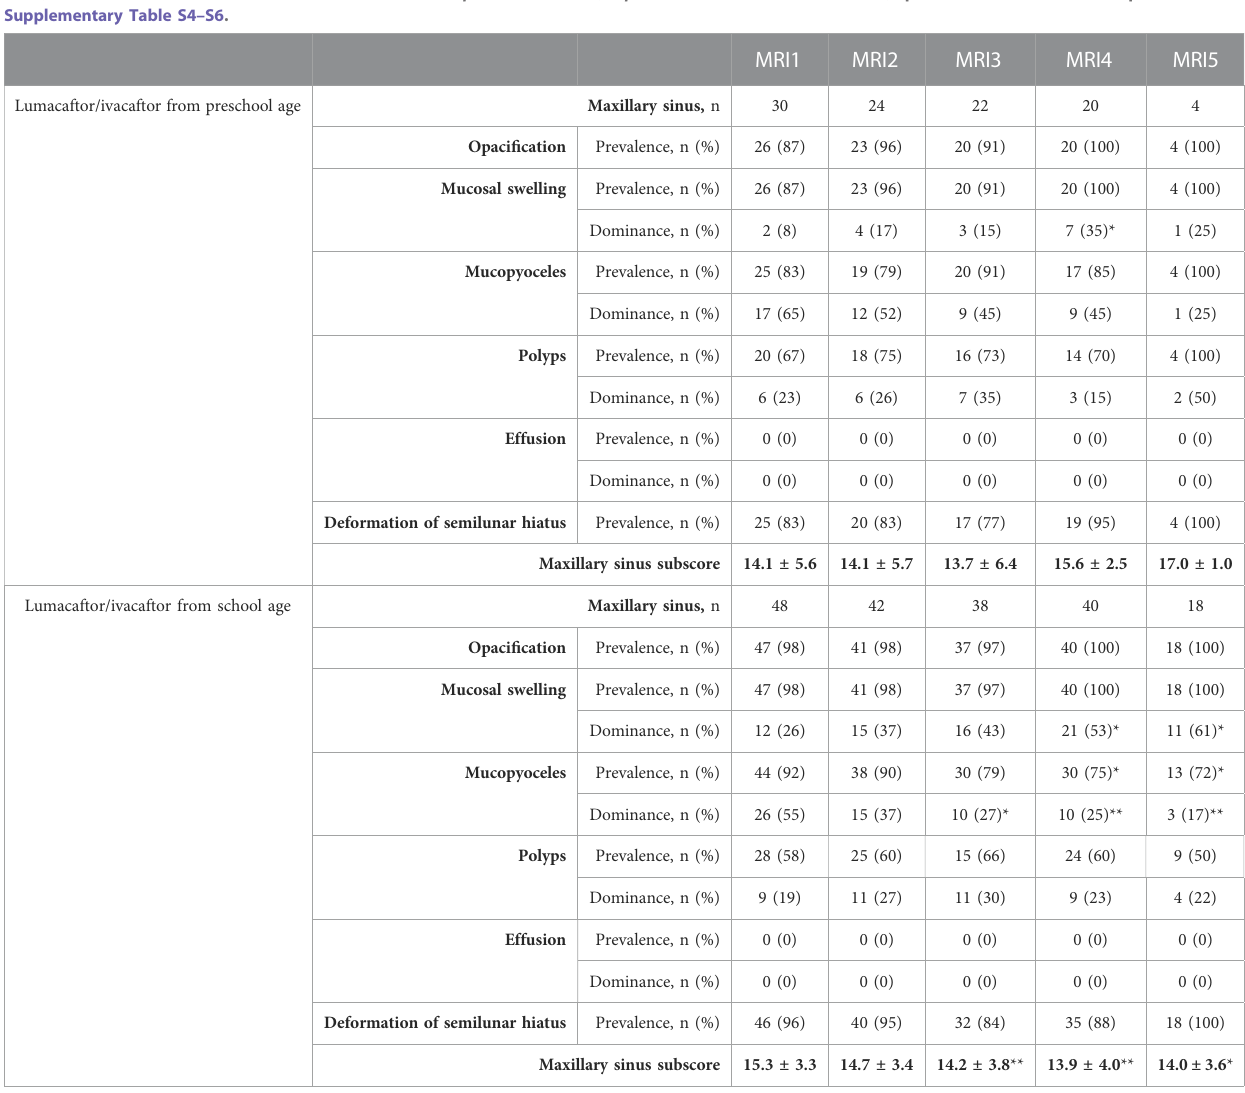
Supplementary Figure S2). The CRS-MRI sum score and the ( p = 0.520 – 0.999 vs. MRI1) (Figure 3,